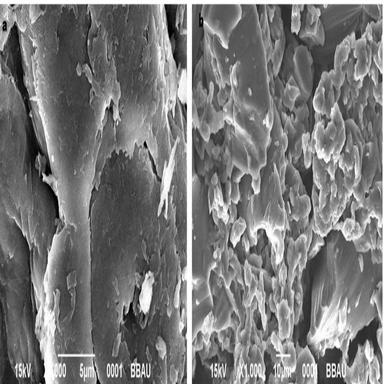
SEM images of the (a) chitosan (b) chit-cl-Poly (AA-co-Am).